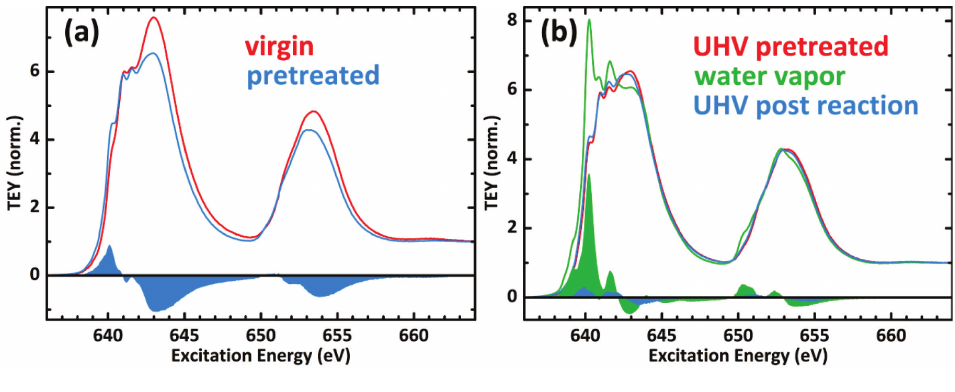
Figure 3. Normalized Mn L-edge of pretreated sample ( x virgin sample with x = 0.8 in UHV; ( b ) Pretreated state in UHV (red), in 0.1 mbar H Ca a bias of +2.5 V against chamber ground (green), and post reaction in UHV (blue).